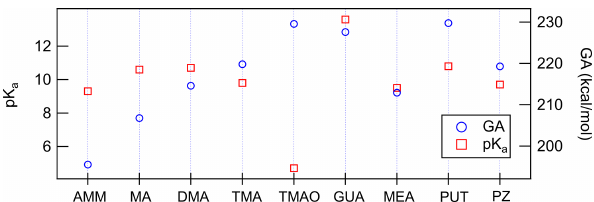
Figure 2. Calculated GA vs. literature p K a values from Haynes (2014).